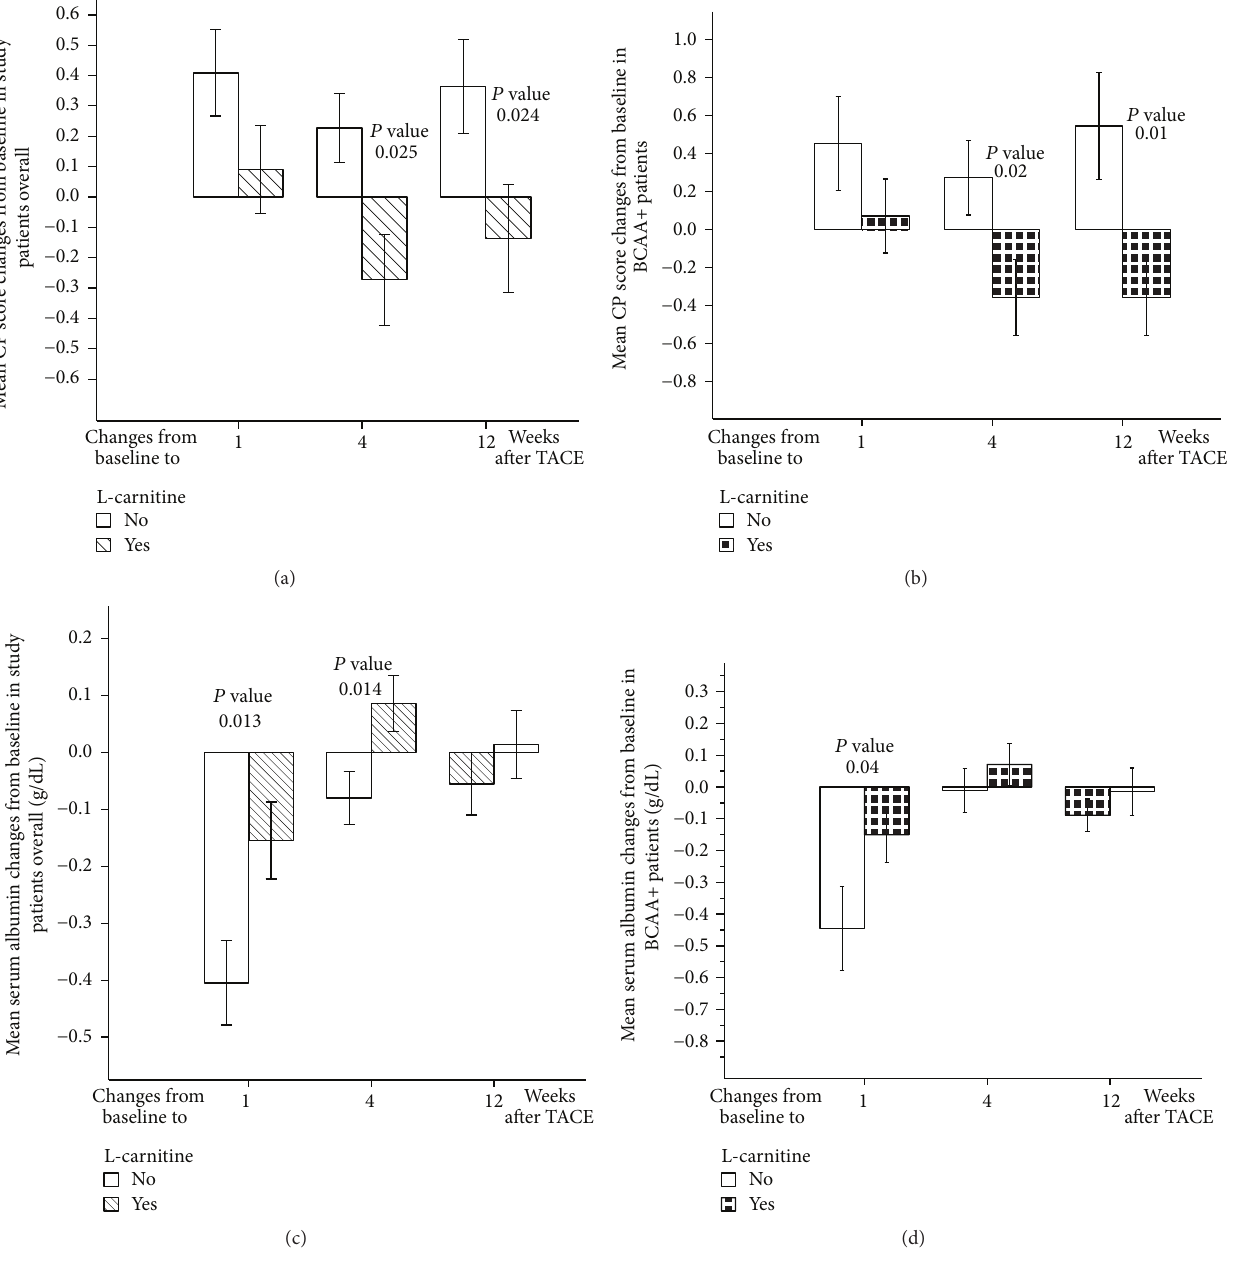
Figure 1: L-carnitine effects on CP score and serum albumin. (a) L-carnitine effects on mean CP score changes from baseline in study patients overall. (b) L-carnitine effects on mean CP score changes from baseline in BCAA+ patients. (c) L-carnitine effects on mean serum albumin changes from baseline in study patients overall. (d) L-carnitine effects on mean serum albumin changes from baseline in BCAA+ patients. CP: Child-Pugh; TACE: transarterial chemoembolization. Error bars represent standard errors. groups revealed significant differences in mean total bilirubin changes from baseline to 1 week after TACE ( 𝑃 < 0.05